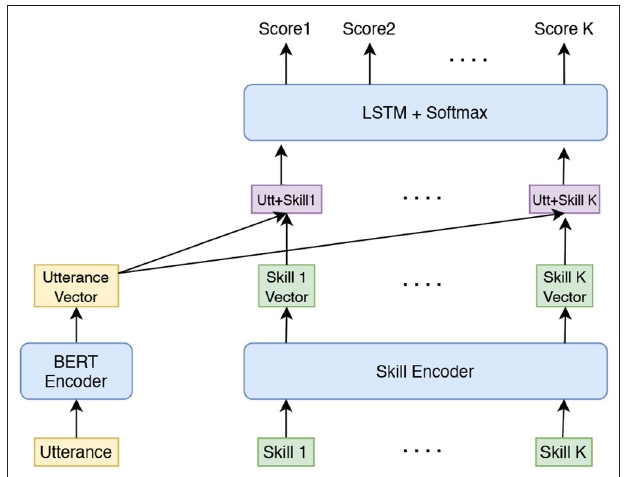
FIGURE 3 | The model architecture of